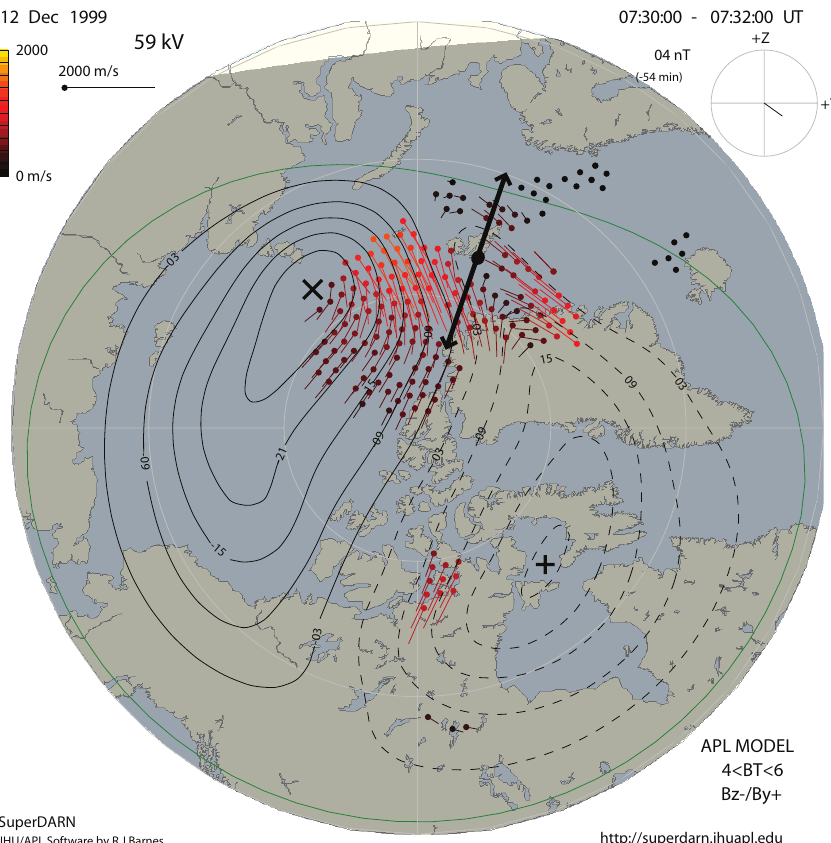
Fig. 14. SuperDARN radar observations of plasma convection during the interval 07:30–07:32 UT. The FOV of the MSP in Ny ˚Alesund (11:00 MLT) is marked. Same format as in Fig.